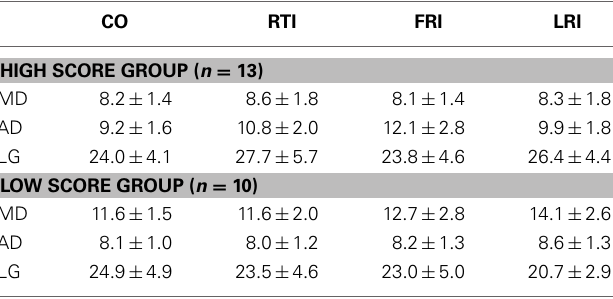
Table 1 | Modulation of muscle activity during control and imagery